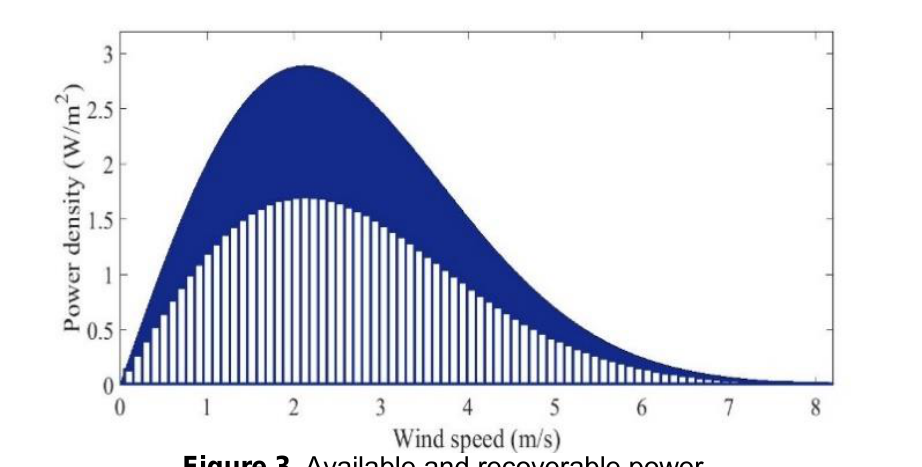
Figure 3. Available and recoverable